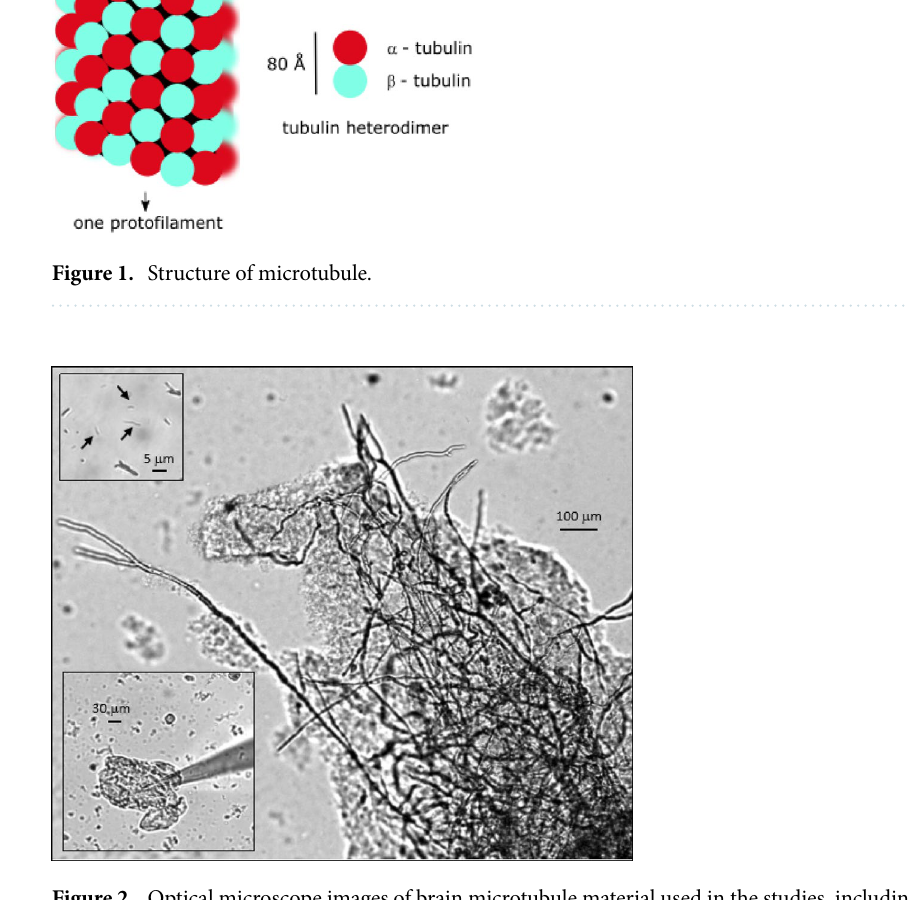
Figure 2. Optical microscope images of brain microtubule material used in the studies, including sheets, bundles and isolated MTs (×10, ×20, ×60), respectively. Upper left inset shows isolated MTs (arrows), as well as small macrotubes (e.g. top right). Lower left shows an MT sheet with apposed patch-clamp